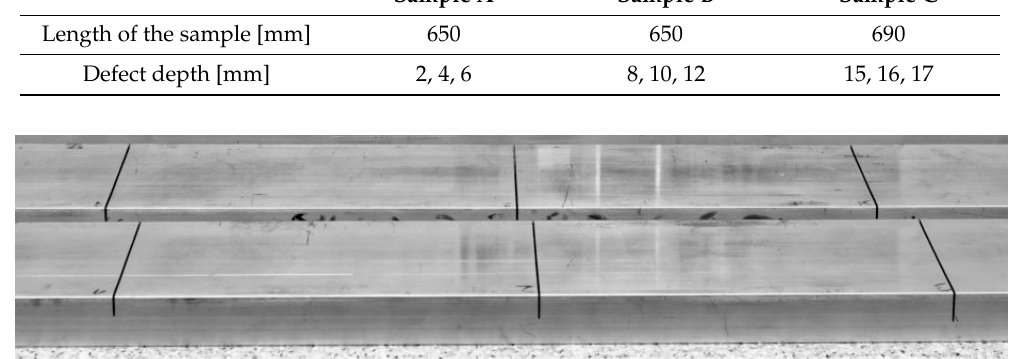
Table 1. Comparison of the tested samples.